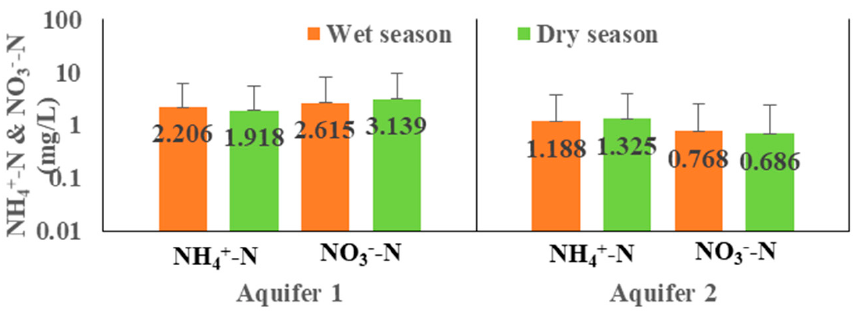
Figure 5. The mean concentrations of NH 4+ -N and NO 3- -N in addition to statistical results in Aquifer 1 and Aquifer 2 between the wet and dry seasons.